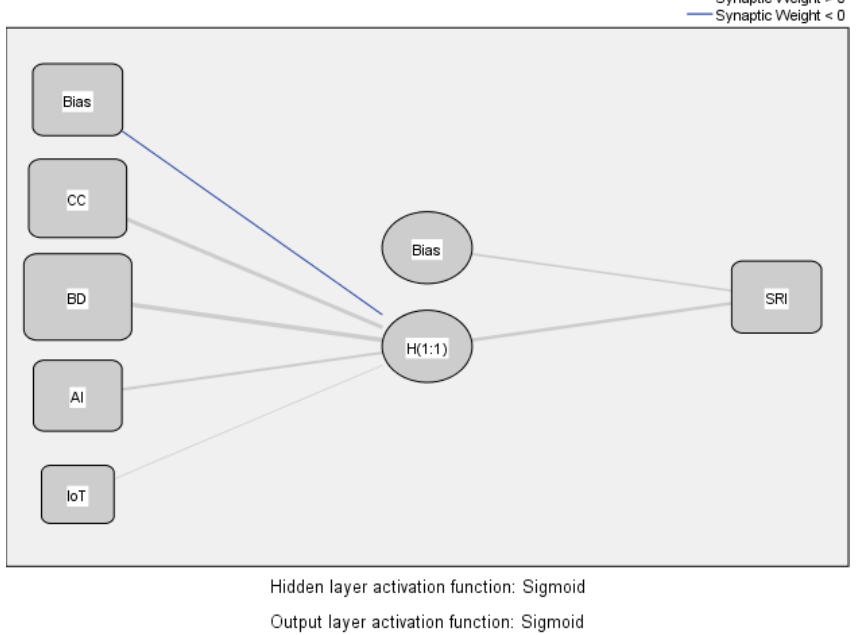
Figure 2. MLP model illustrating the influences of digital technologies on the sustainability reporting index. Source: own construction using SPSS v.20.